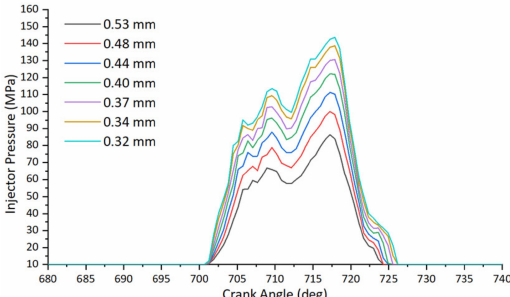
Figure 22. Fuel injection pressure under varied nozzle diameters.